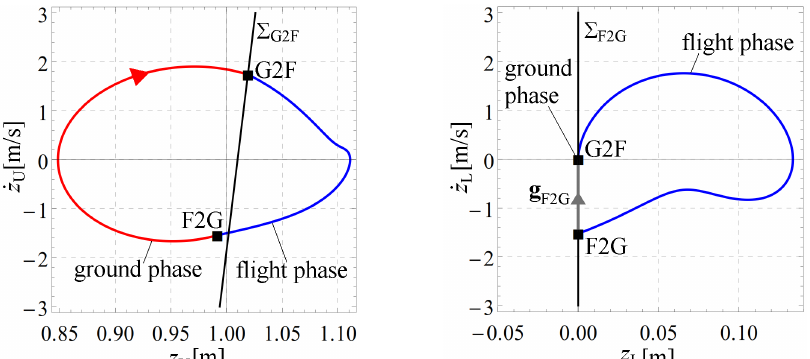
Figure 4. Phase portraits for particle m U ( left panel) and m L ( right panel). The switching surfaces are indicated by black lines. Here, the jump of state variable ˙ z L can be seen. The trajectory of particle m L in the ground phase is represented by point G2F.